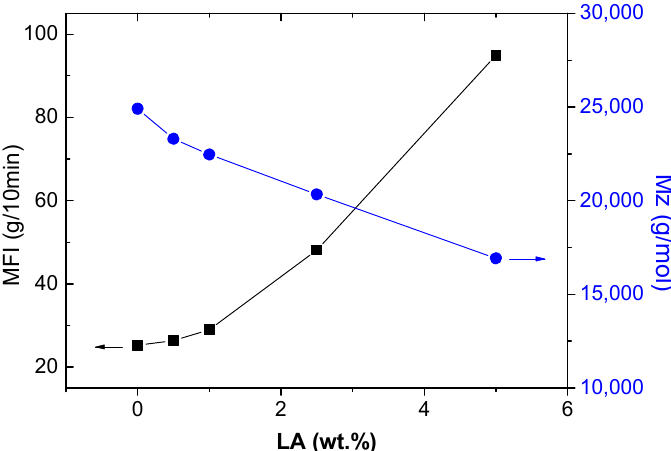
Figure 6. MFI values and viscosity molecular weight (M z ) of the star-branched polymers versus the content of 5-aminoisophthalic acid.